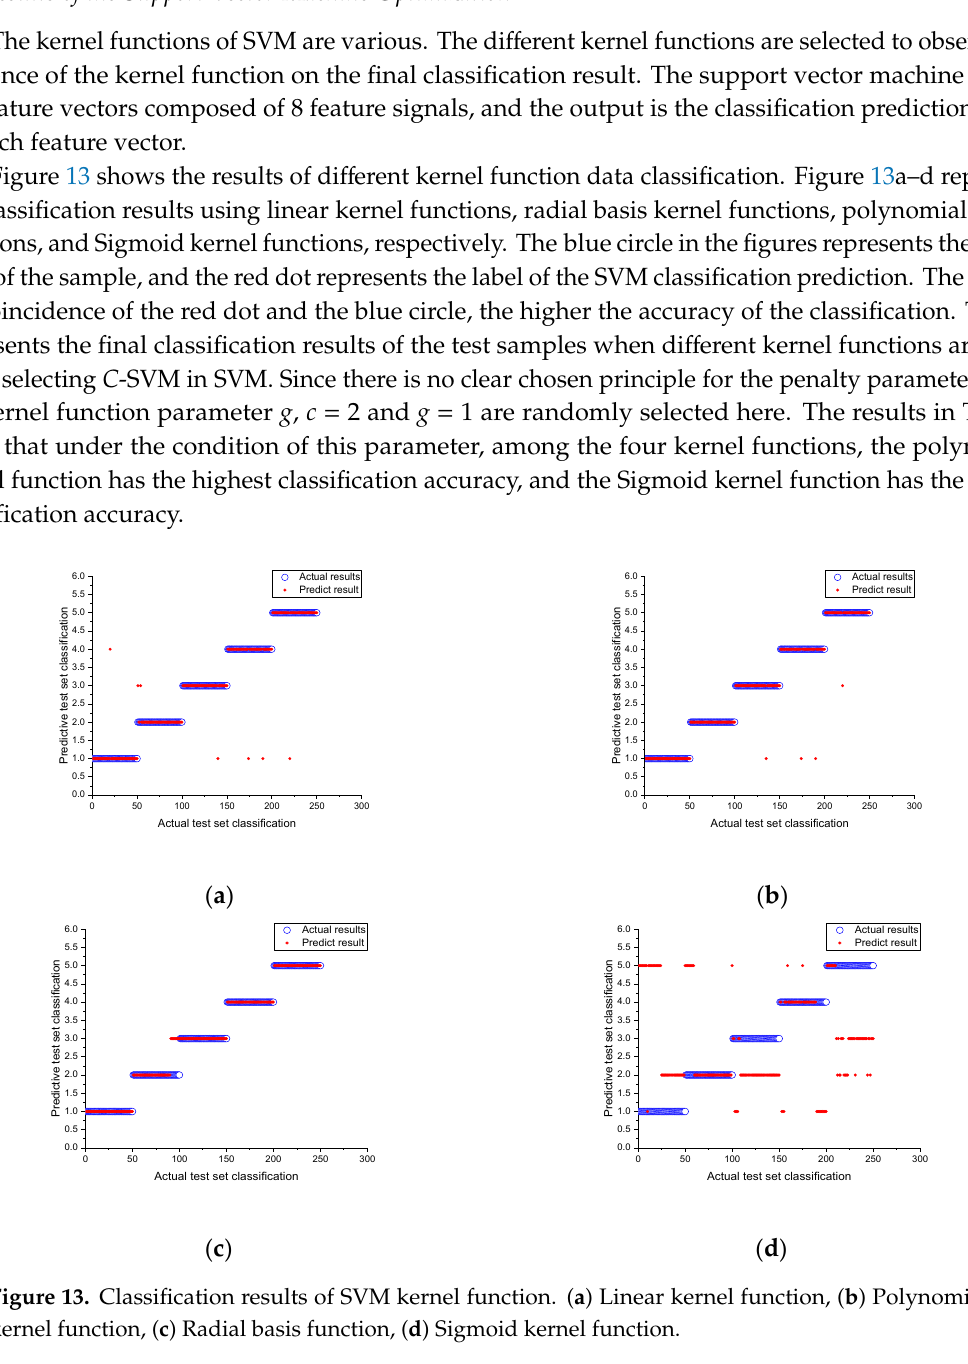
Figure 12. PNN iterative process and results after PSO optimization. ( a ) Iterative optimization process , ( b ) Final classification results.